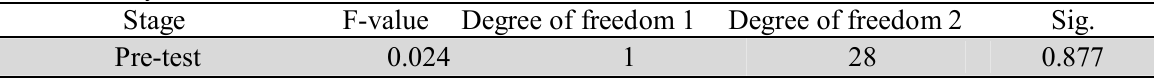
The summary of Levin test